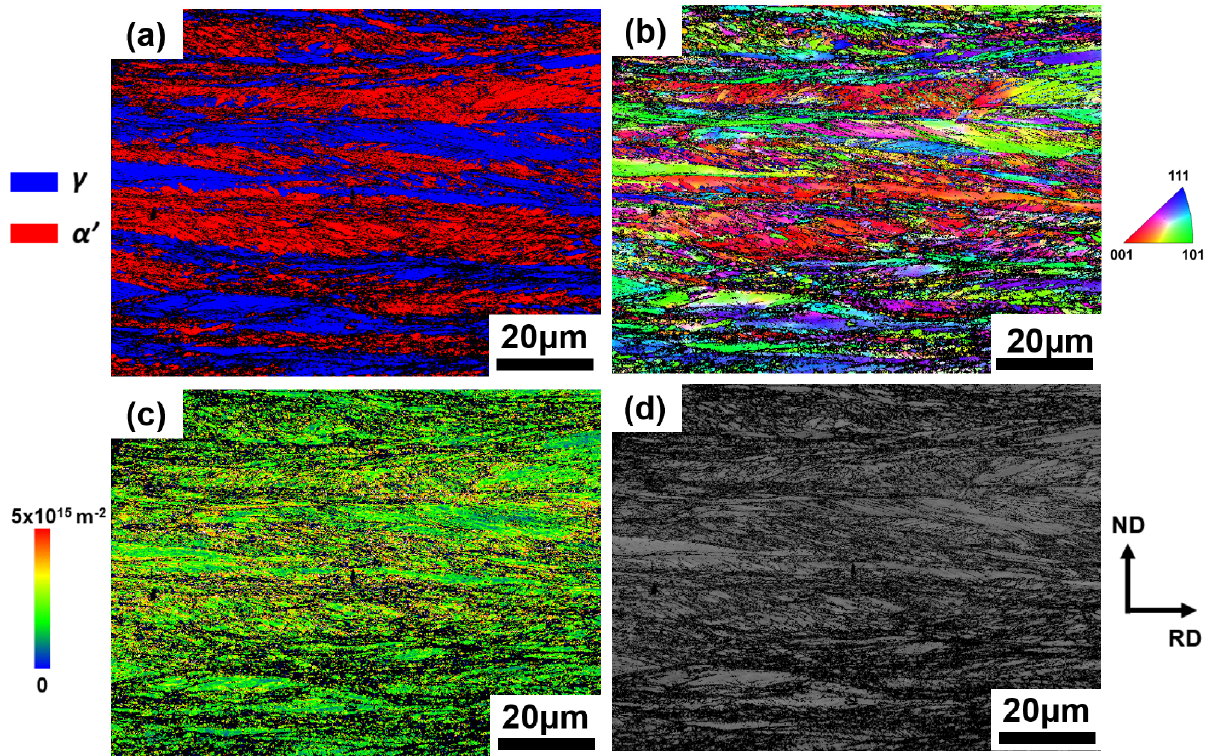
Figure 8. EBSD maps showing the initial microstructures of the HR + WR + CR20% + PT350 sample. ( a ) Phase map showing the distribution of martensite phase (red color) and retained austenite phase (blue color). ( b ) IPF map showing the grains orientations of the sample. ( c ) The map of GND density estimated based on the kernel average misorientation. ( d ) Band contrast map showing image quality of the mapping. RD: rolling direction, ND: normal direction. γ : austenite, α ’: martensite.